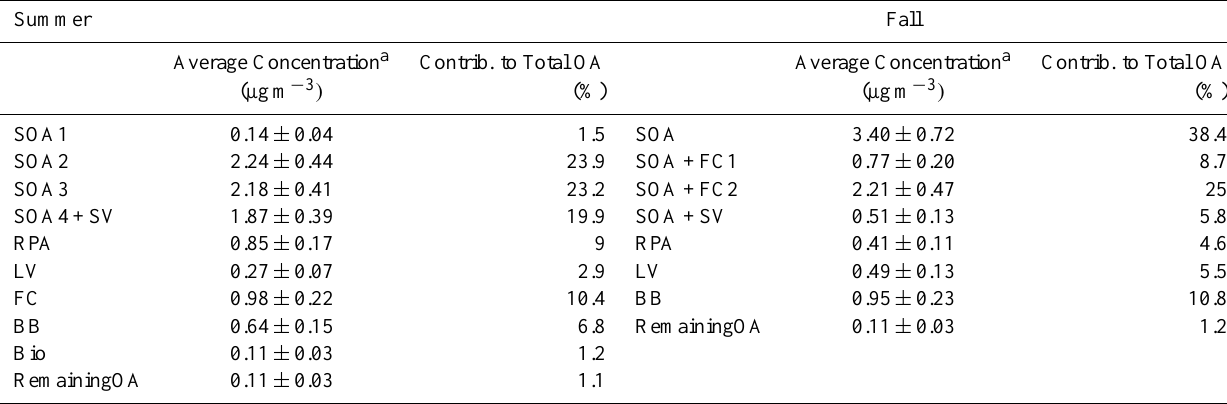
Table 3. Average Factor Concentrations and Contributions to OA during SOAR 2005.